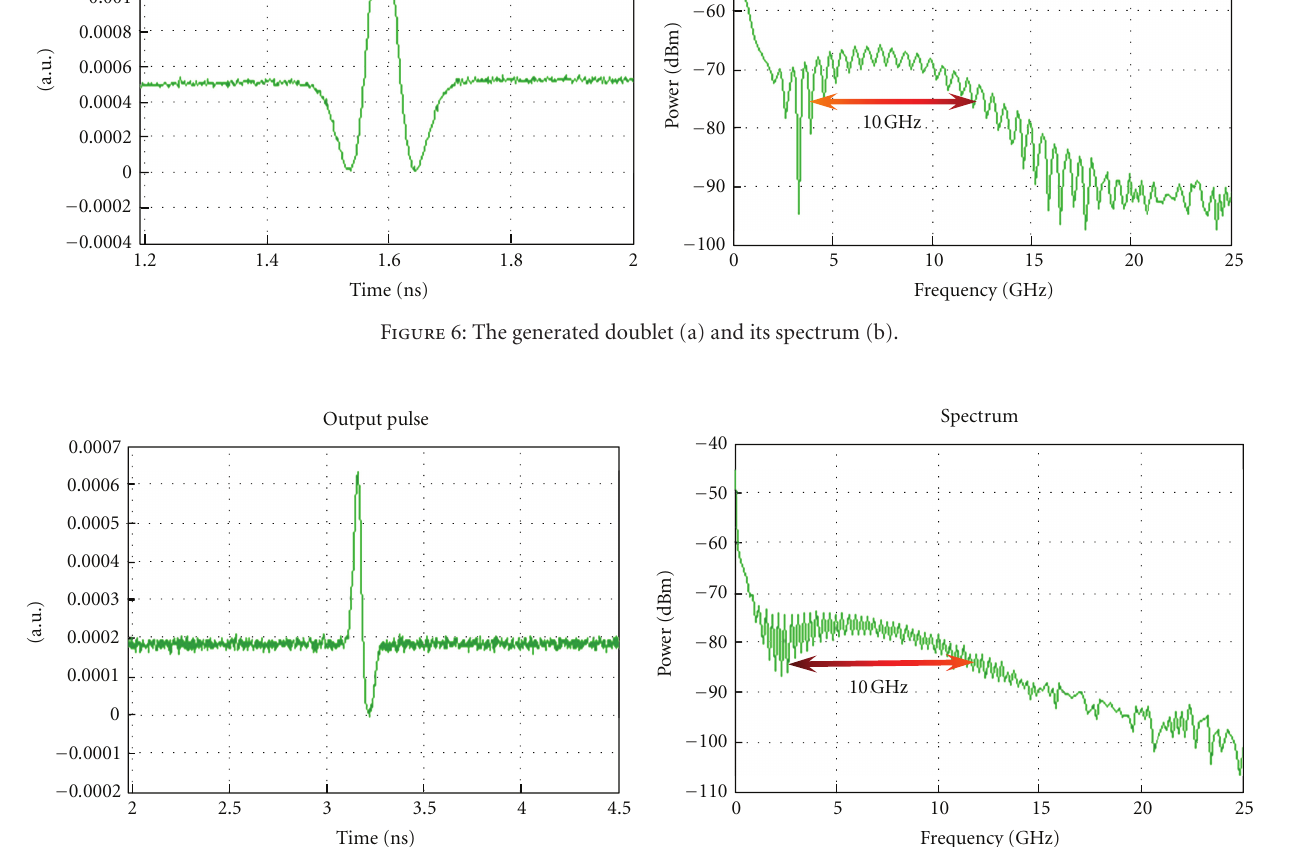
Figure 7: The generated monocycle (a) and its spectrum